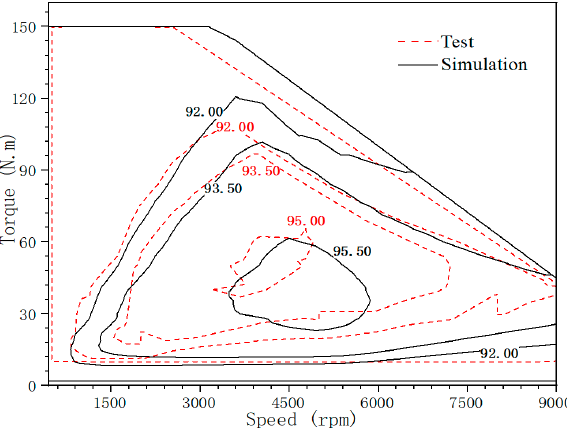
Figure 11. Temperature comparison between simulation and prototype test.